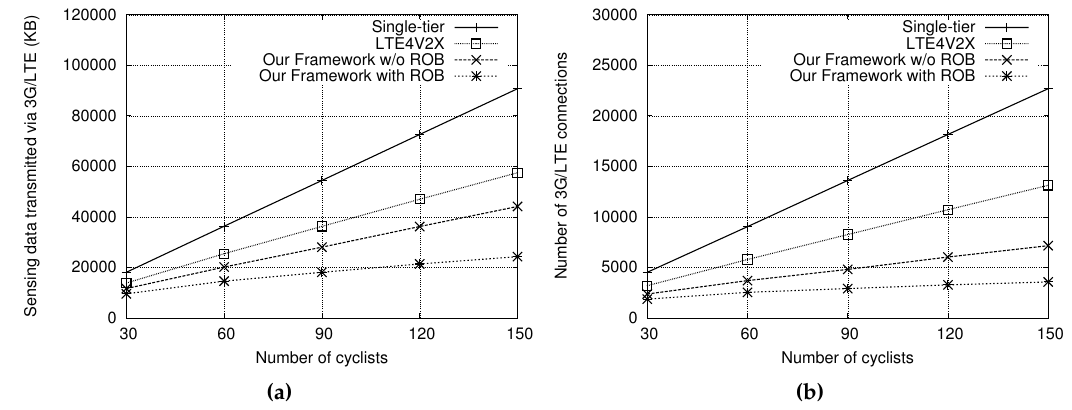
Figure 4. Comparisons of: ( a ) the sensing data amount transmitted via 3G/LTE; and ( b ) the numbers of 3G/LTE connections under the sensing data update interval of five